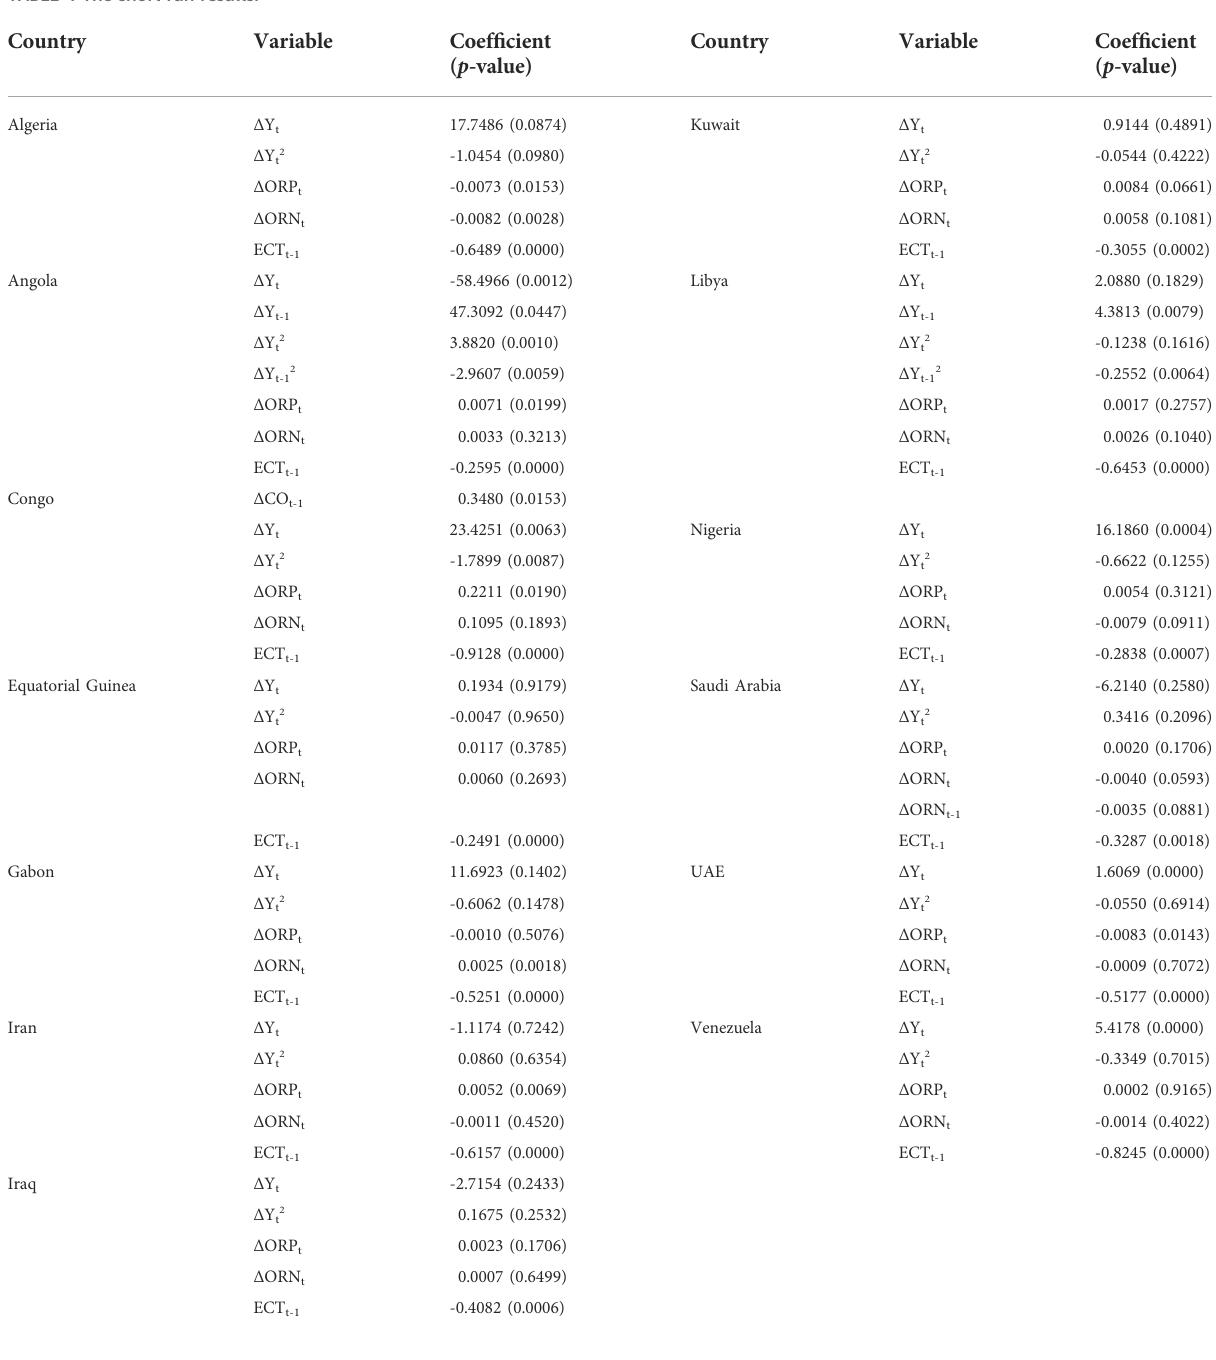
TABLE 4 The short run